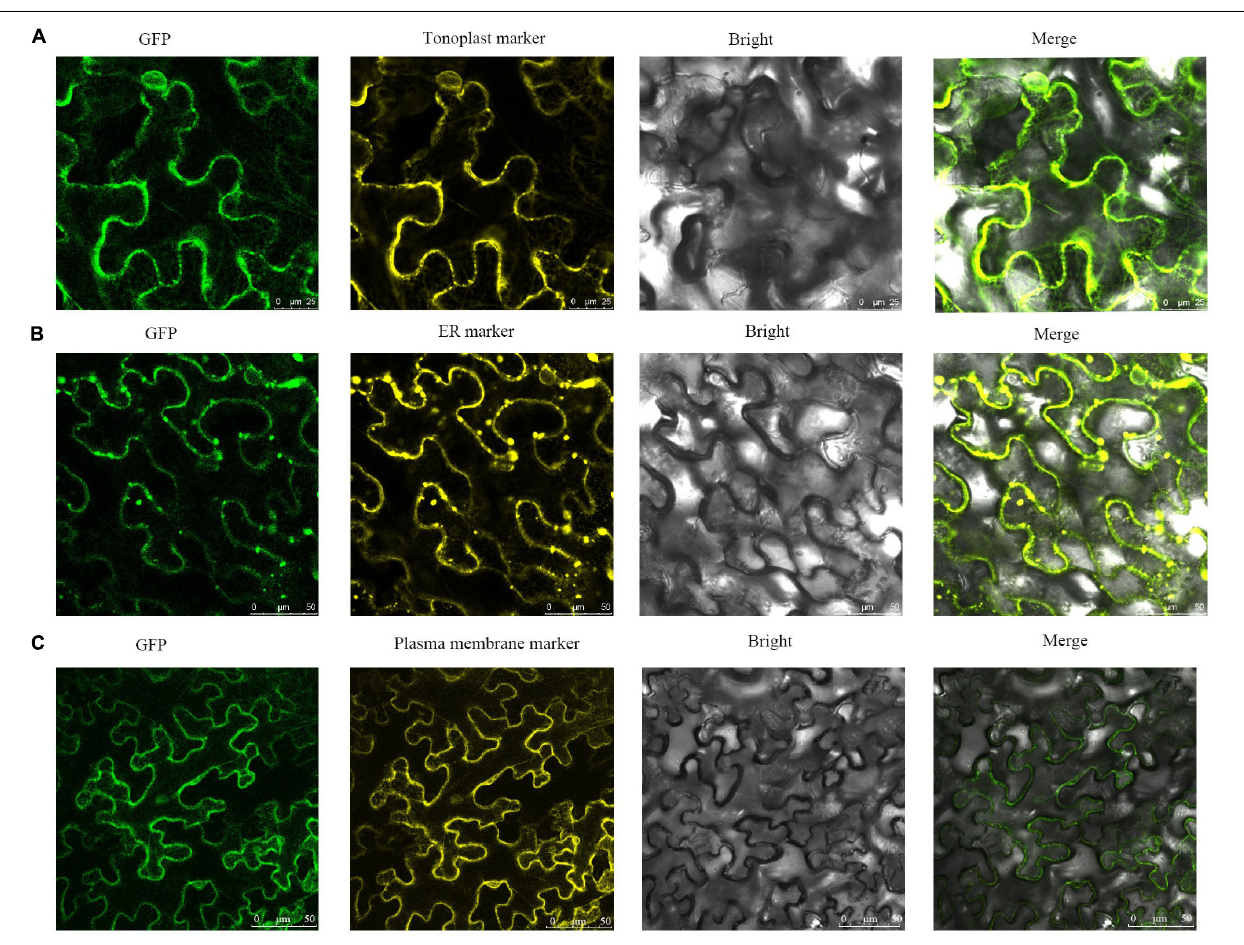
Arabidopsis and rice, suggesting functional similarity and an evolutionarily conserved nature. While two, four, three, three, four, one, three, and two orthologous proteins from other species of the Solanaceae family (namely S. pennellii , S. tuberosum , N. attenuata , N. tabacum , C. annuum , N. sylvestris , C. baccatum